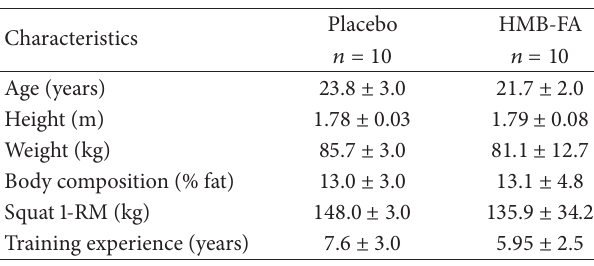
Table 1: Characteristics of participants.